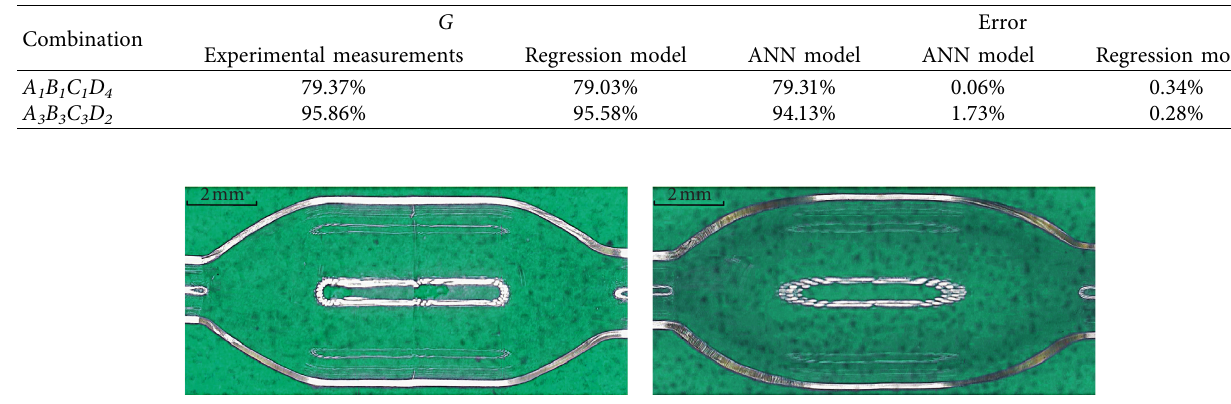
Table 7: Comparison results and their relative errors of two combinations.